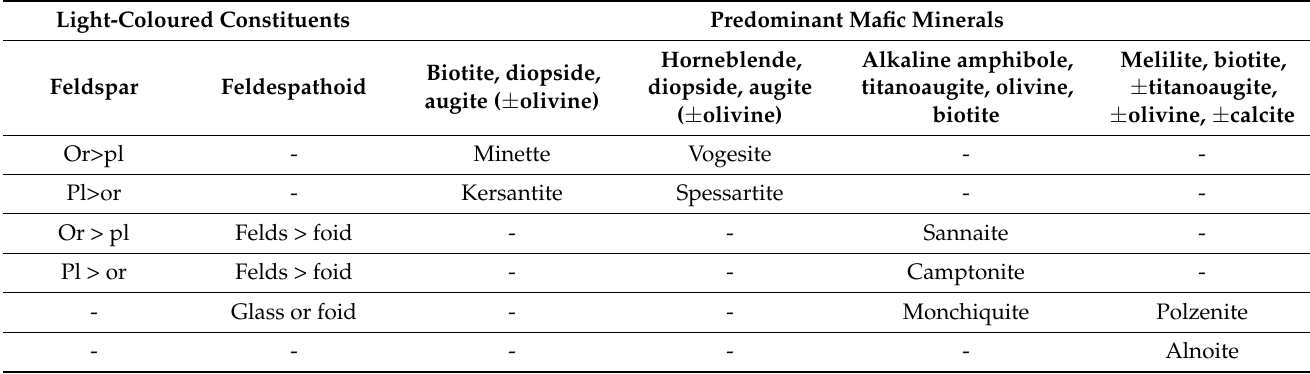
Table 7. Lamprophyre classification (Streckeisen, 1978)